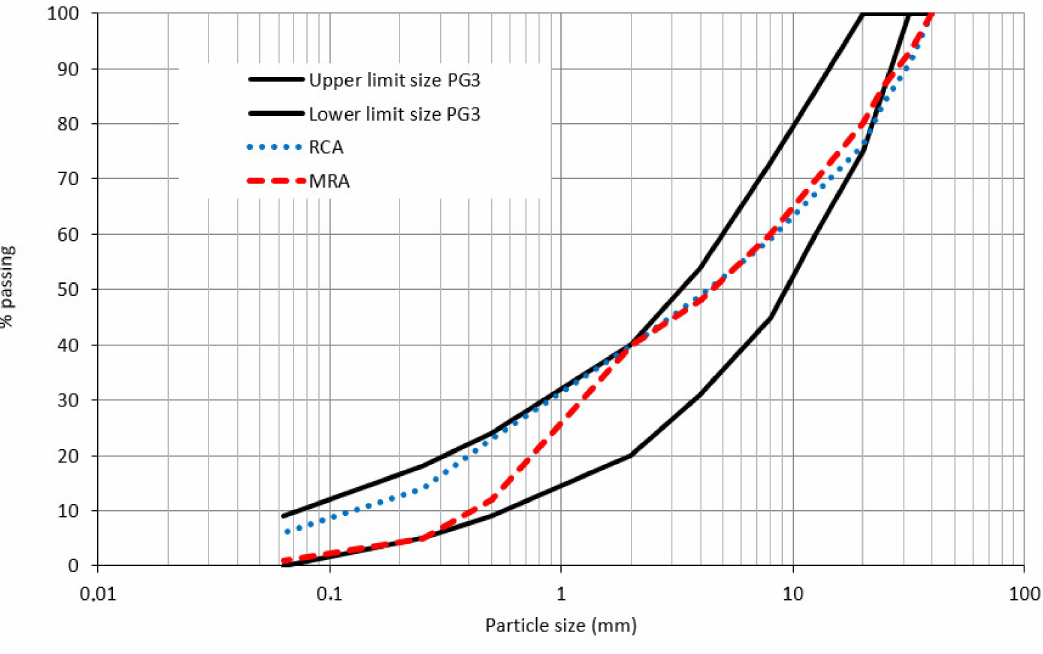
Figure 3. Particles’ size distribution curves compared with the particle size distribution